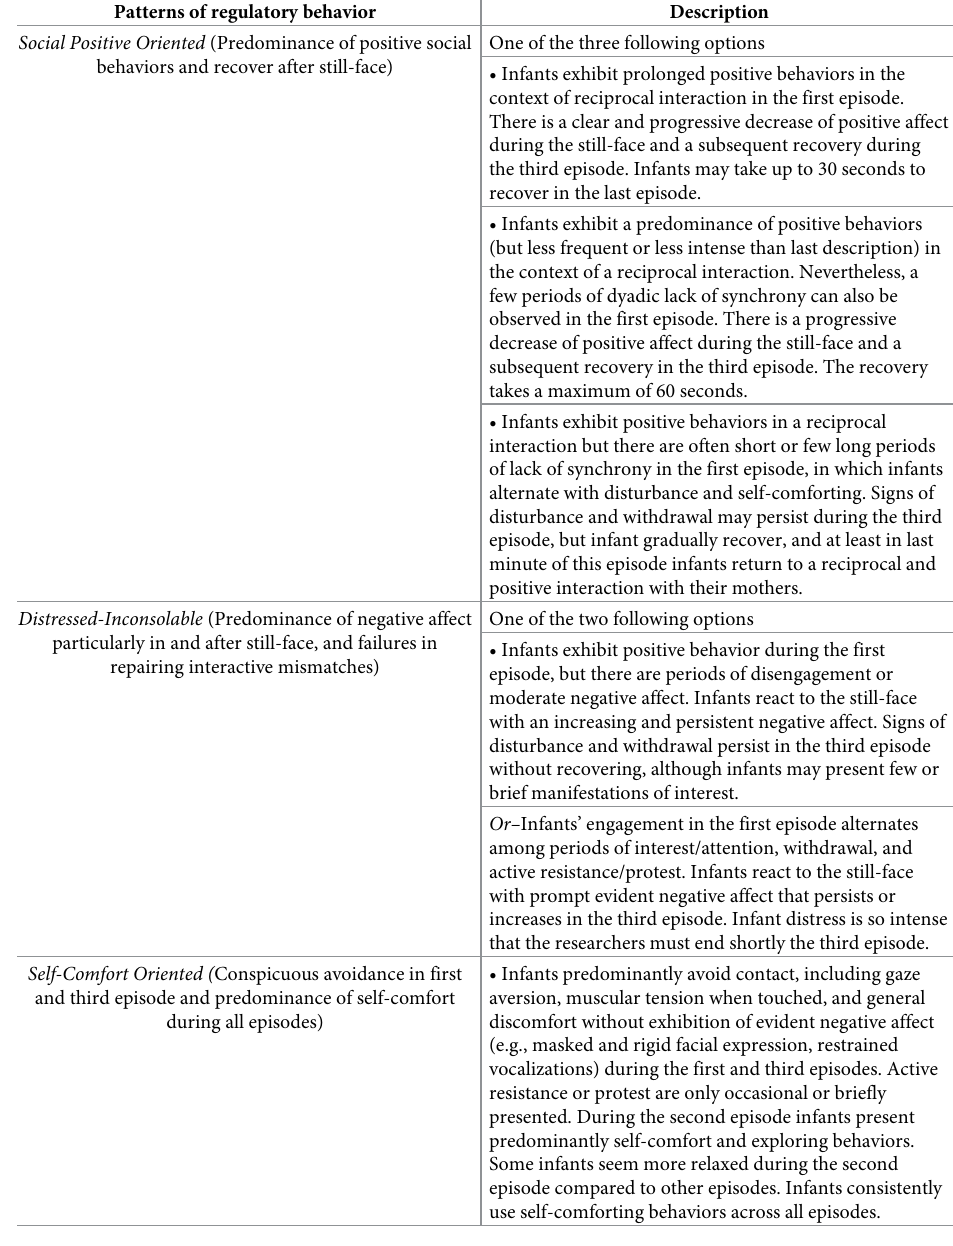
Table 2 was adapted from [7] with author